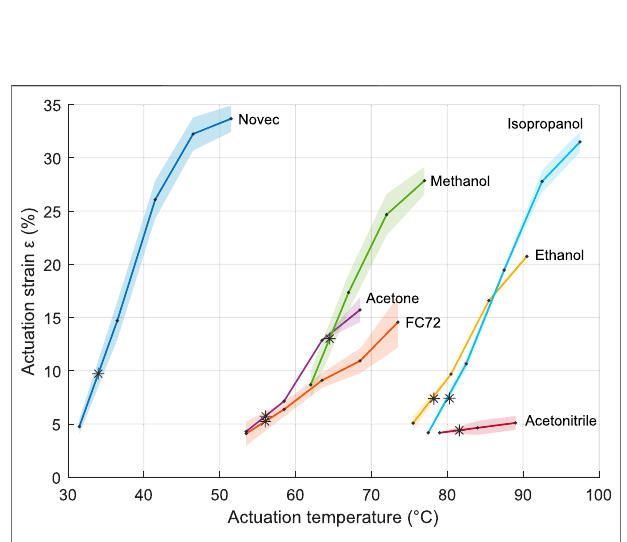
FIGURE 5 | Actuation strain as a function of the temperature for the different fl uids. The shaded areas represent the standard deviation; the data points are in black. The stars indicate the boiling